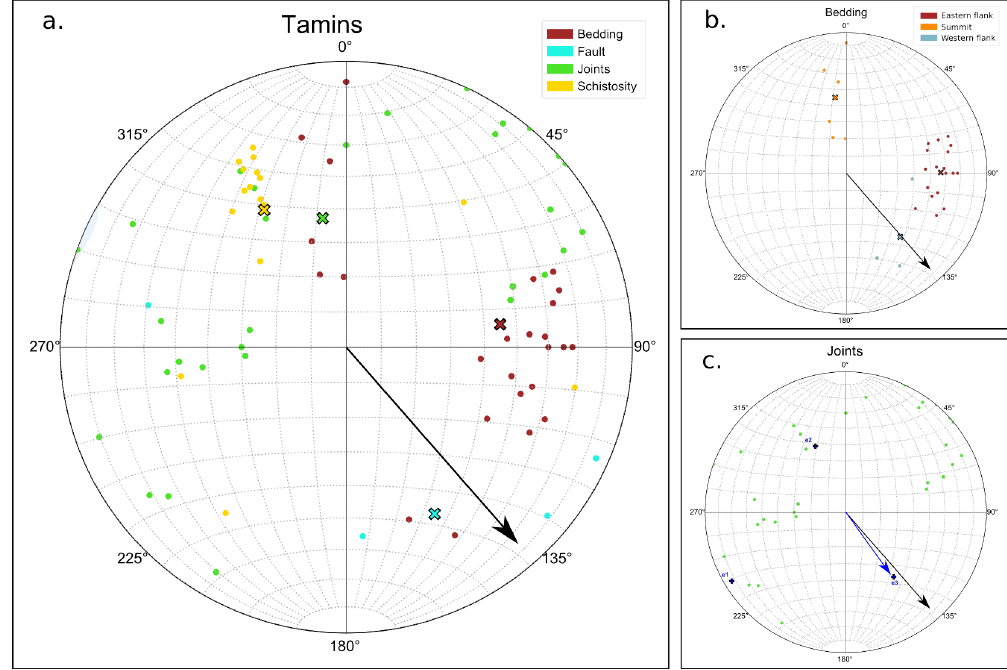
Figure A2. Stereonets of ( a ) all the structural data of the Tamins rockslide ( b ) data of the bedding and ( c) data of the joints. Dots are the poles of the great circles and crosses are mean the poles. The blue crosses (e1, e2 and e3) are the three-axis of the Bingham best-fit plane. The blue arrow pointing e3, the trend and plunge, and the black arrow shows the direction of the